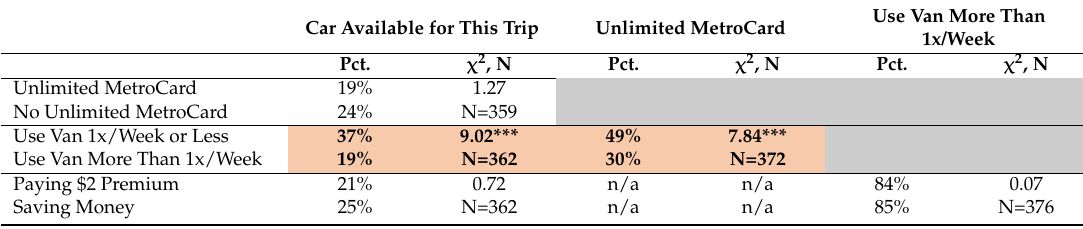
Table 6. Associations between respondent transport